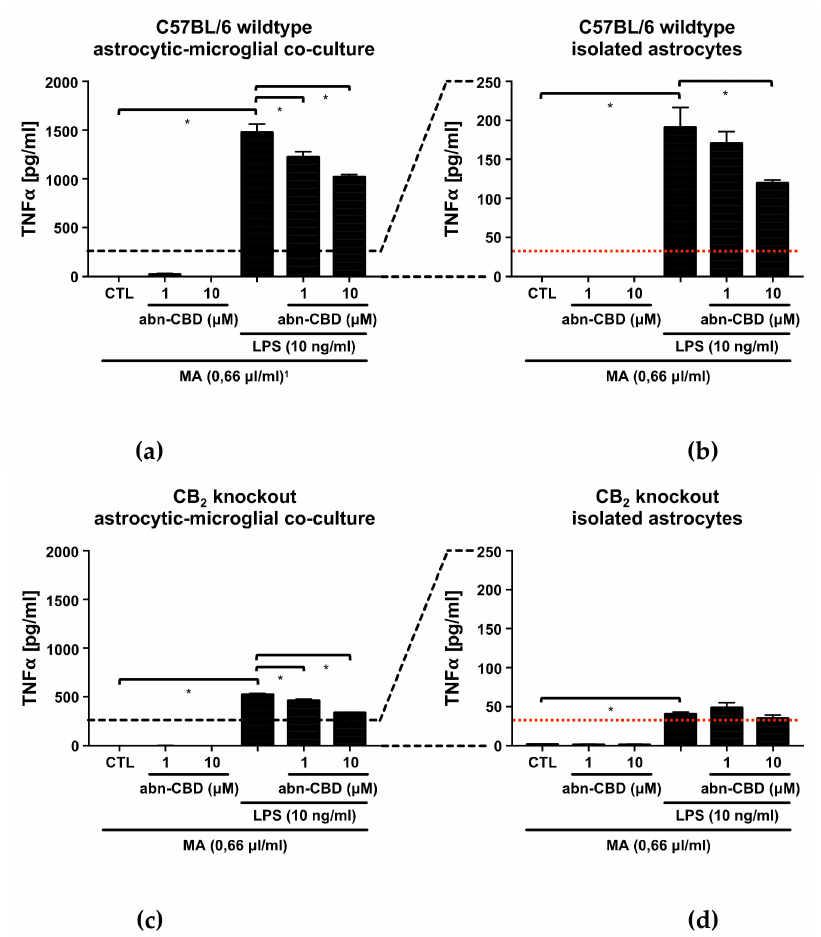
Figure 2. TNF α measurement in supernatants from astrocytic-microglial cocultures ( a , c ) and isolated astrocytes ( b , d ) from C57BL / 6 wildtype ( a , b ) and CB 2 knockout mice ( c , d ). Data is expressed as mean ± SEM, n = 8 in each group. Statistical analysis was done using one-way ANOVA followed by Bonferroni’s post-test. * p < 0.05. Note the di ff ering scaling of the y -axis between cocultures ( a , c ) and isolated astrocytes ( b , d ). The lower detection limit of the assay as given by the manufacturer and estimated on basis of the standard curve is shown by the red dotted line. 1 All groups received the same concentration (0.66 µ L / mL) of the solvent methylacetate (MA) as contained in 10 µ M abn-CBD